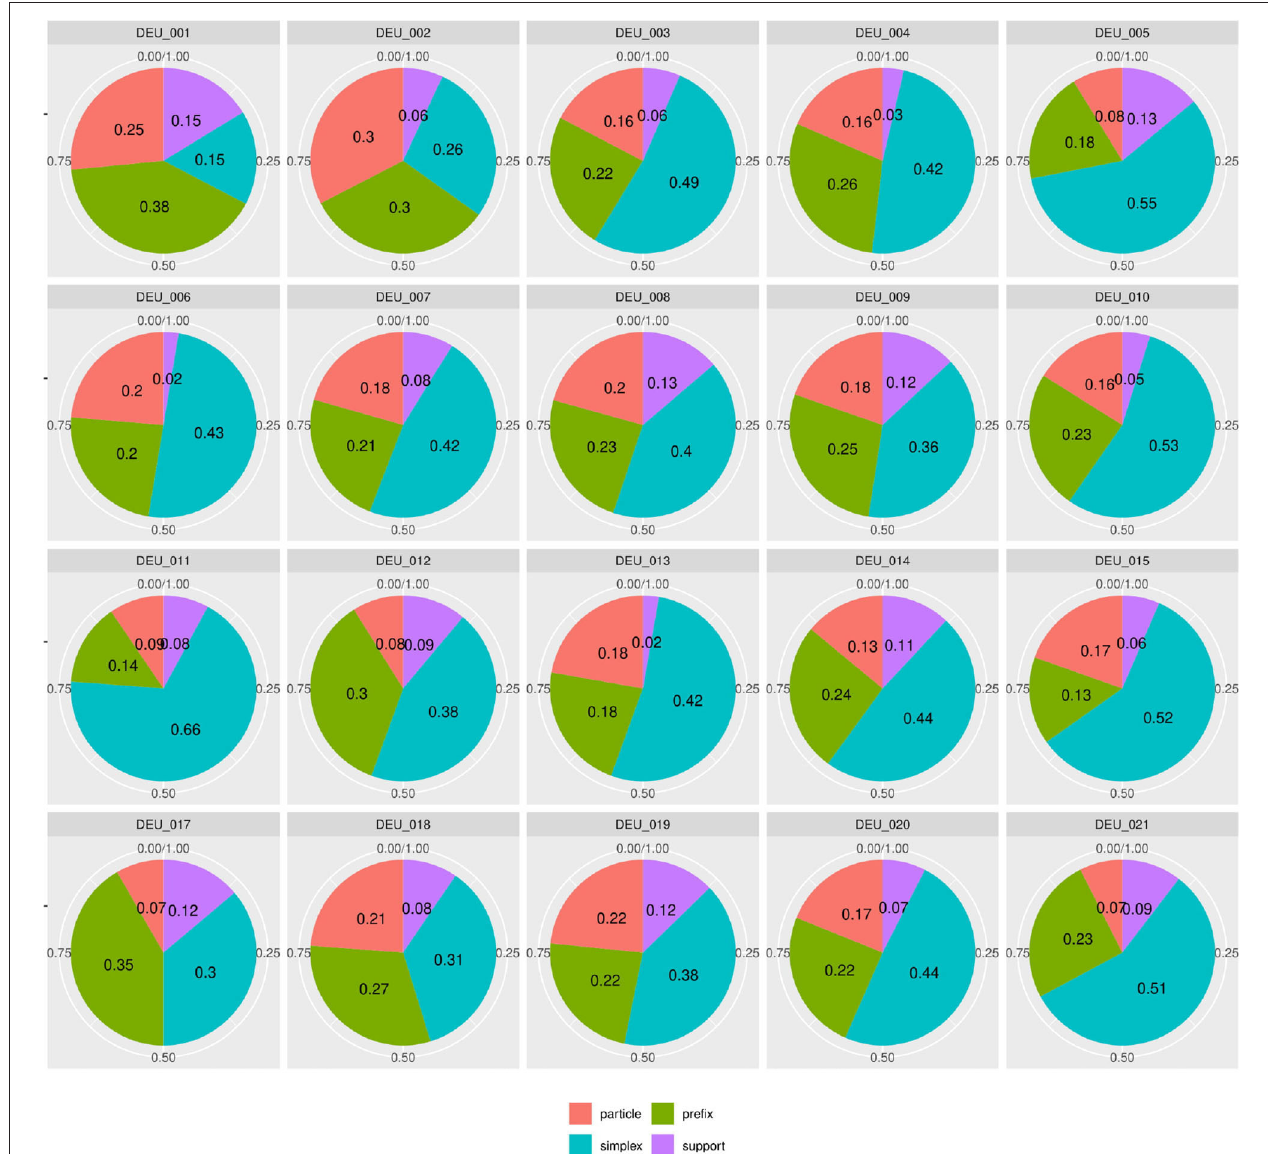
FIGURE 3 | Individual distributions of lexical verb subclasses in the native speaker documents in Kobalt show striking differences in proportions. Pie charts are usually not ideal tools for distribution visualization, but were in our view the best choice in this case, cf. footnote